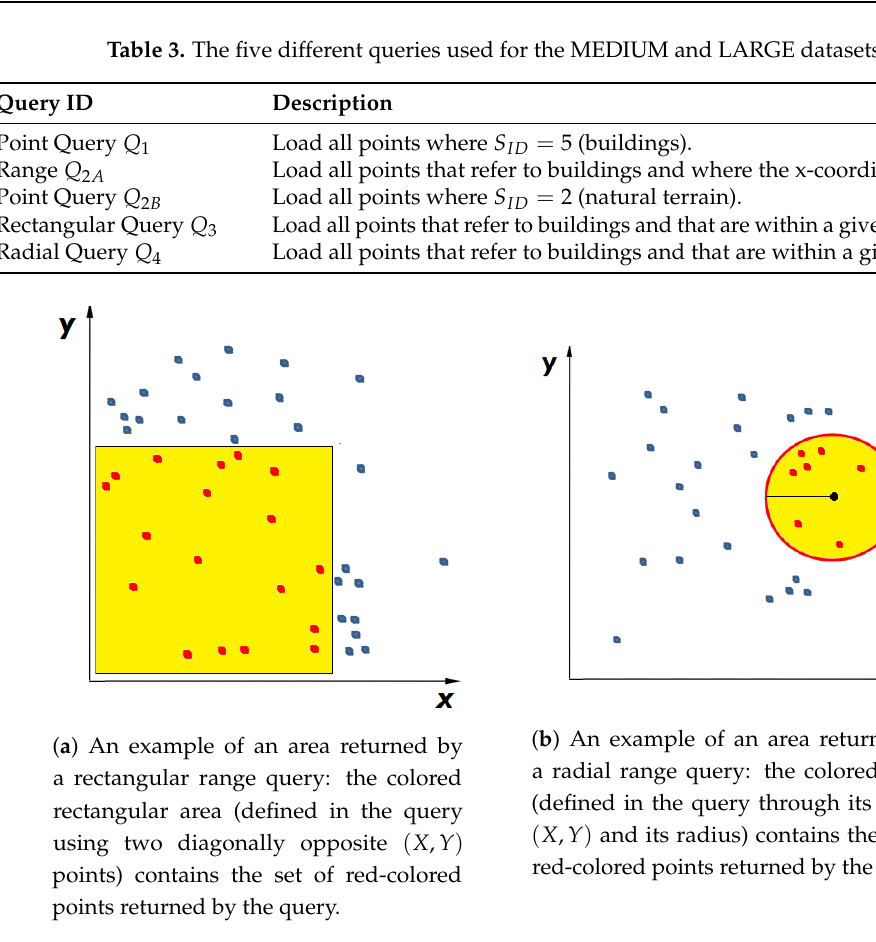
Figure 4. Two different range queries: rectangular ( a ) and radial ( b